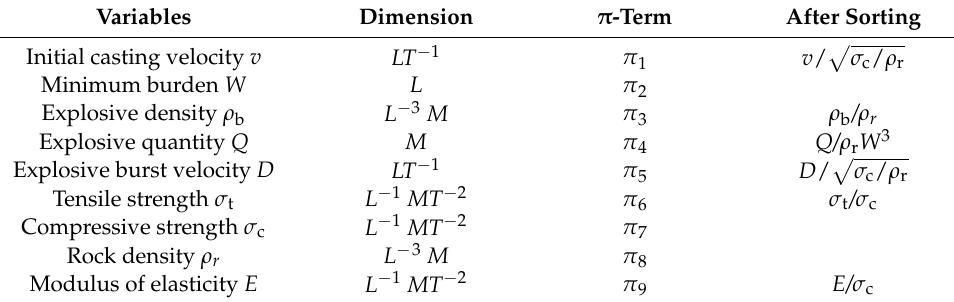
Table 1. Parameters related to initial casting